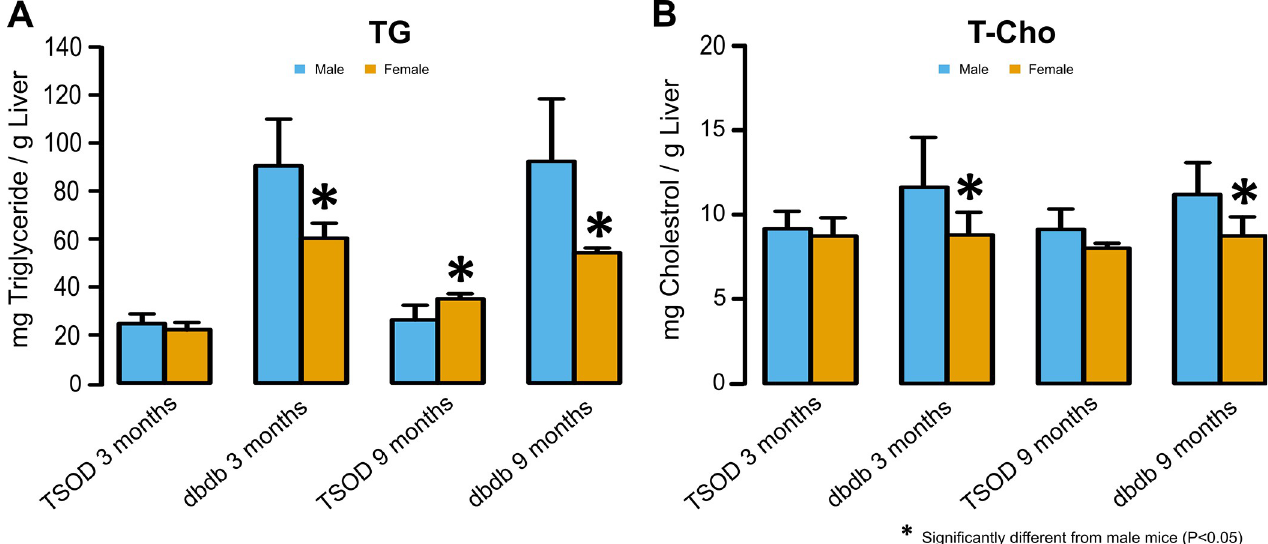
Fig 6. Triglyceride (TG) and total cholesterol (T-Cho) levels in the liver. A) At 3 months of age, TG levels in the livers of TSOD mice show no significant sex difference; however, at 9 months, they are significantly higher in females than in males (two-tailed t-test). For db/db mice, hepatic TG levels are significantly higher in male mice than in females at 3 and 9 months of age (one-tailed t-test for young mice and two-tailed t-test for old mice). B) T-Cho levels in the livers of male db/db mice are significantly higher than those in females at 3 and 9 months of age (one-tailed t-test for young mice and two-tailed t-test for old